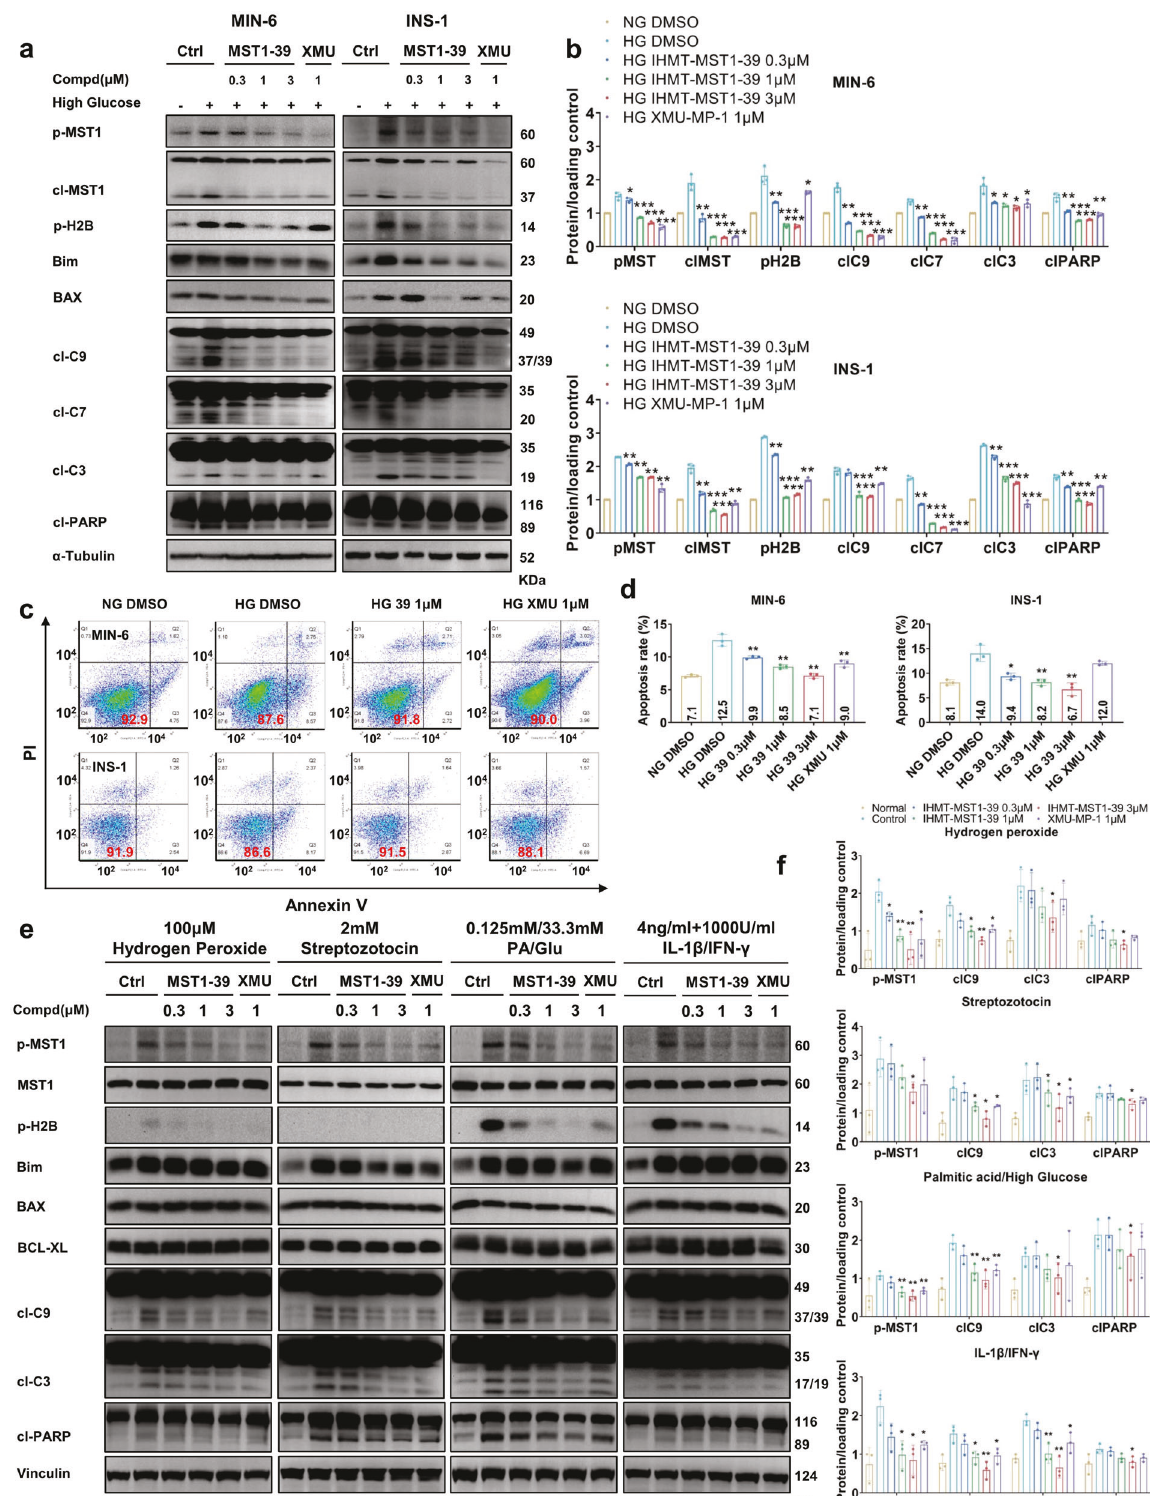
after exposure to various diabetogenic conditions in MIN-6 cells, and observed improved cell survival following IHMT-MST1-39 treatment in both MIN-6 and INS-1 cells (Supplementary Fig. S3c, d). Consistently, we also observed protective effects of IHMT- MST1-39 against cellular apoptosis induced in diabetogenic conditions in primary isolated islets from murine, leporid, and Signal Transduction and Targeted Therapy (2023)